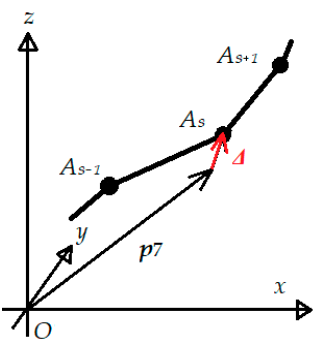
Figure 8. A vector difference Δ between the calculated position of the position vector of the p 7 effector and the position of the A s points.